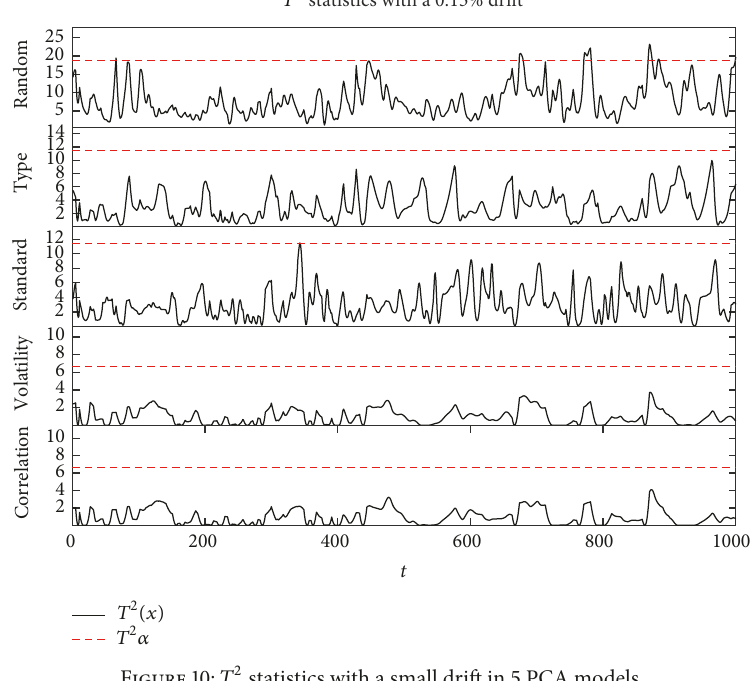
Figure 10: 𝑇 2 statistics with a small drift in 5 PCA models.